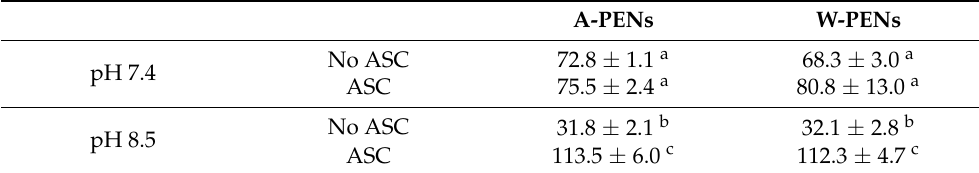
Table 3. The percentage of the cumulative release of PENs after 72 h at two different pH values (7.4 and 8.5) and the presence and absence of